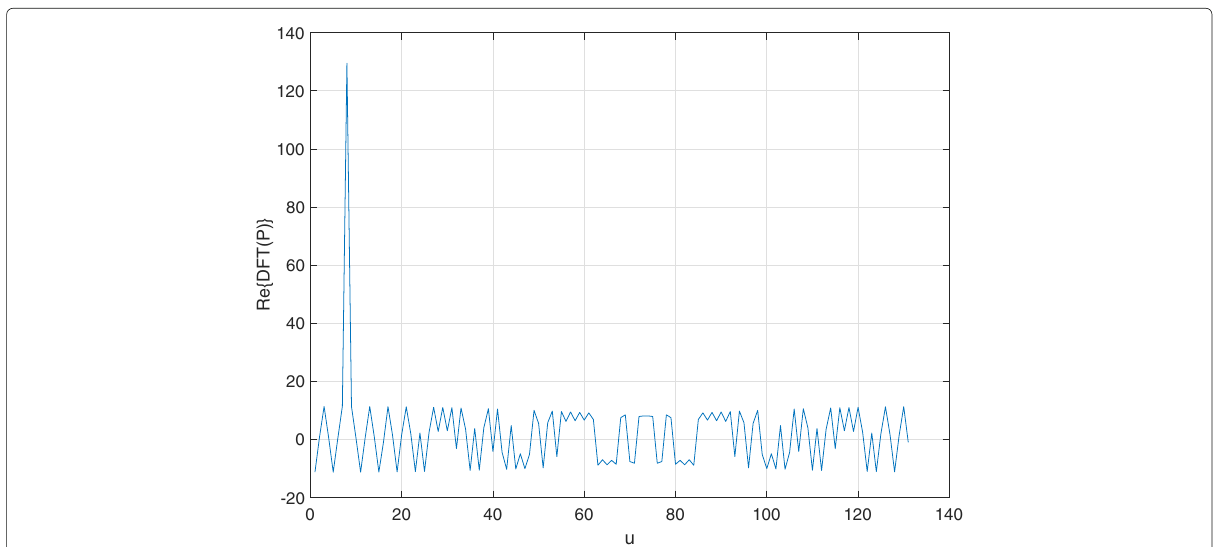
Fig. 2 Re { DFT ( p ) } versus u , ZC sequence has root u =